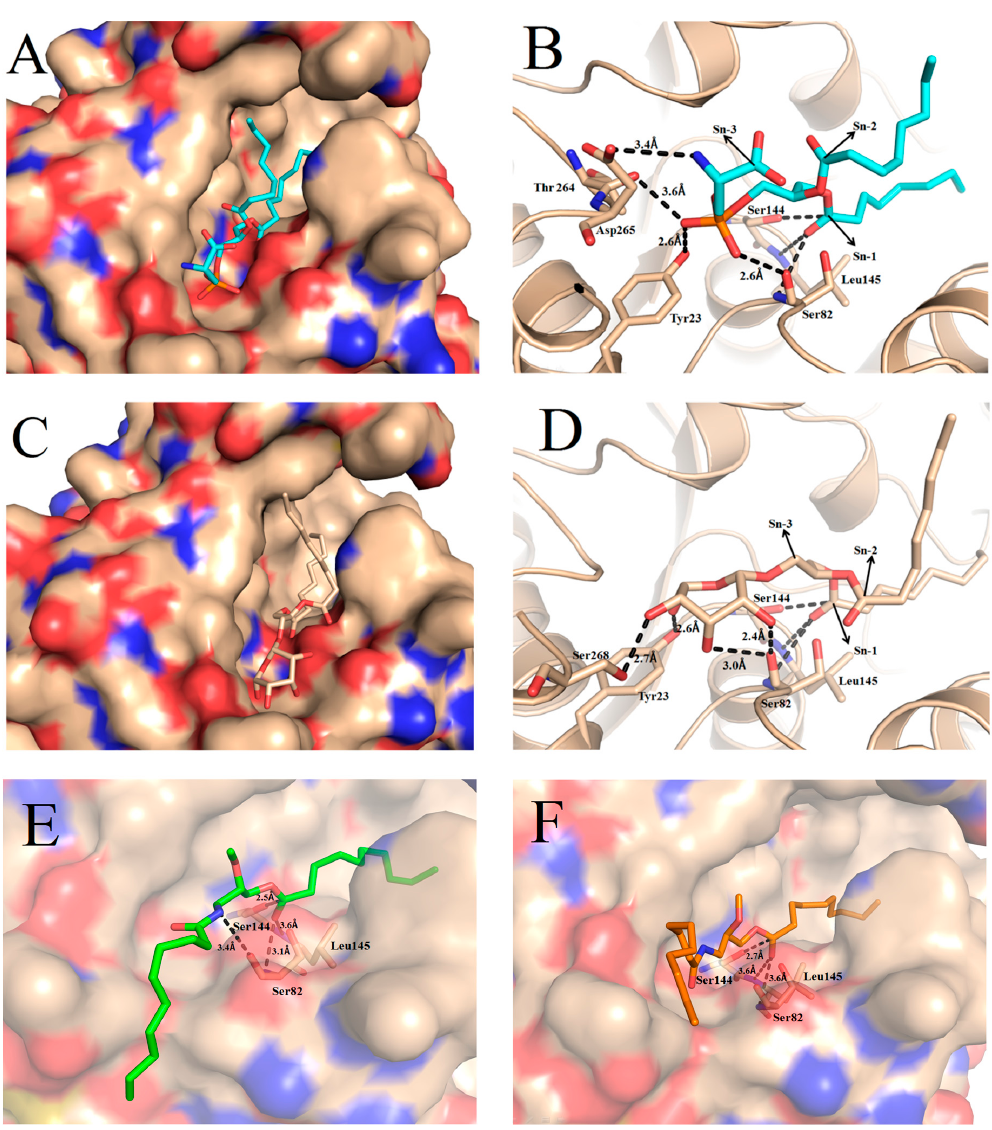
Figure 6. Docking of DiC8-PS ( A , B ), DiC8-MGDG ( C , D ) and 1,3-DDG (S2), 1,3-DDG (R2) DDG enantiomers ( E , F ) into GZEL catalytic pocket. The left images ( A , C ) are electrostatic potential maps and surface view of different substrates with GZEL. The right images ( B , D ) are views from above and show in detail interactions of substrate with the residues in the catalytic pocket. The galactosyl and phosphatidyl groups at the sn-3 position and acyl chains at the sn -1 and sn -2 positions of the glycerol backbone are indicated by arrows. The catalytic Ser144, Ser82 and Leu145 used to form the oxyanion hole and other related residues that interact with substrate are shown in